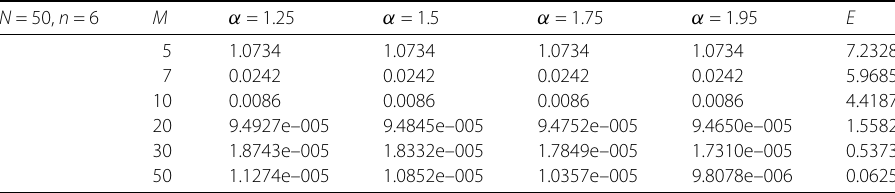
Table 3 The maximum absolute error for different M , N , n and α corresponding to Problem 3 at t = 1 N = 50, n = 6 M α = 1.25 α =